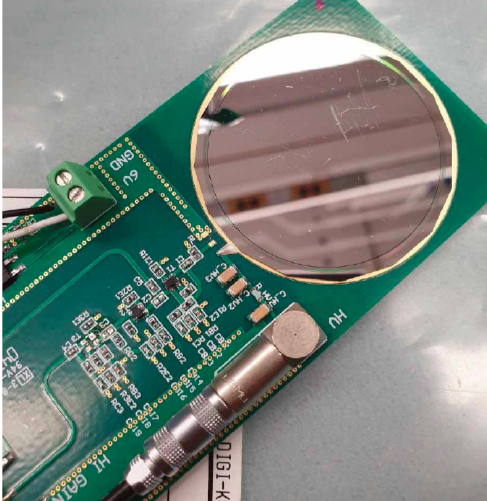
Fig. 2.View of the Silicon detector to be sent into space in collaboration with NASA (AGILE project) together with the readout electronics built in